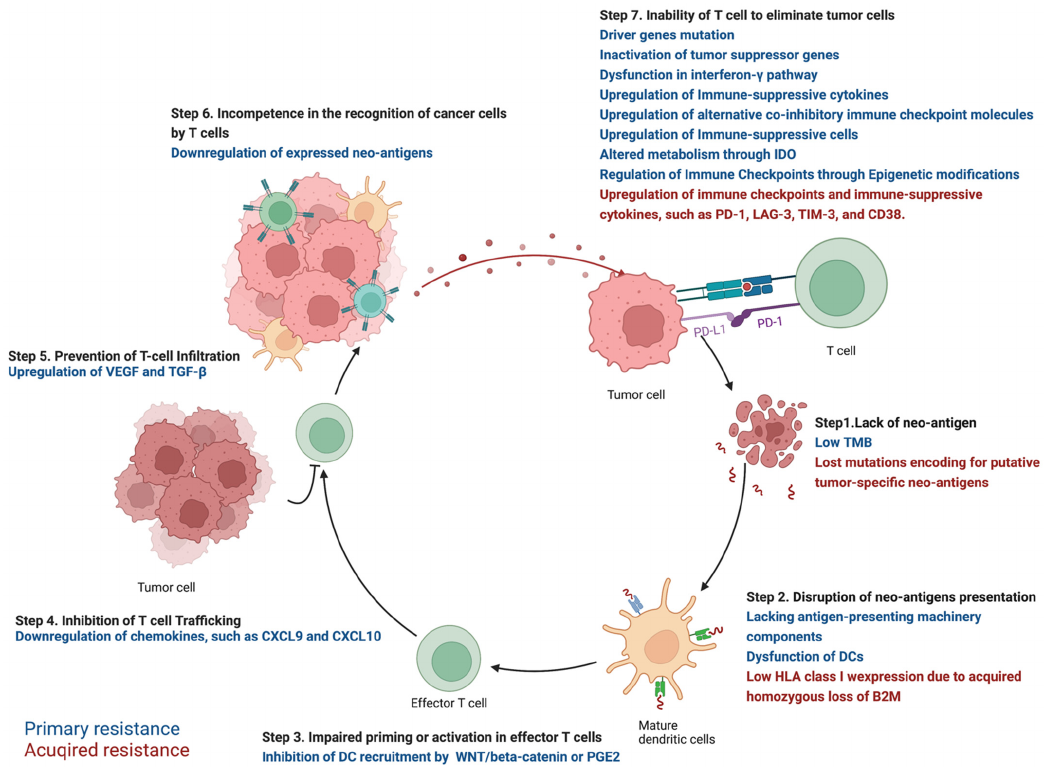
Figure 1. Primary and acquired mechanisms against ICIs in